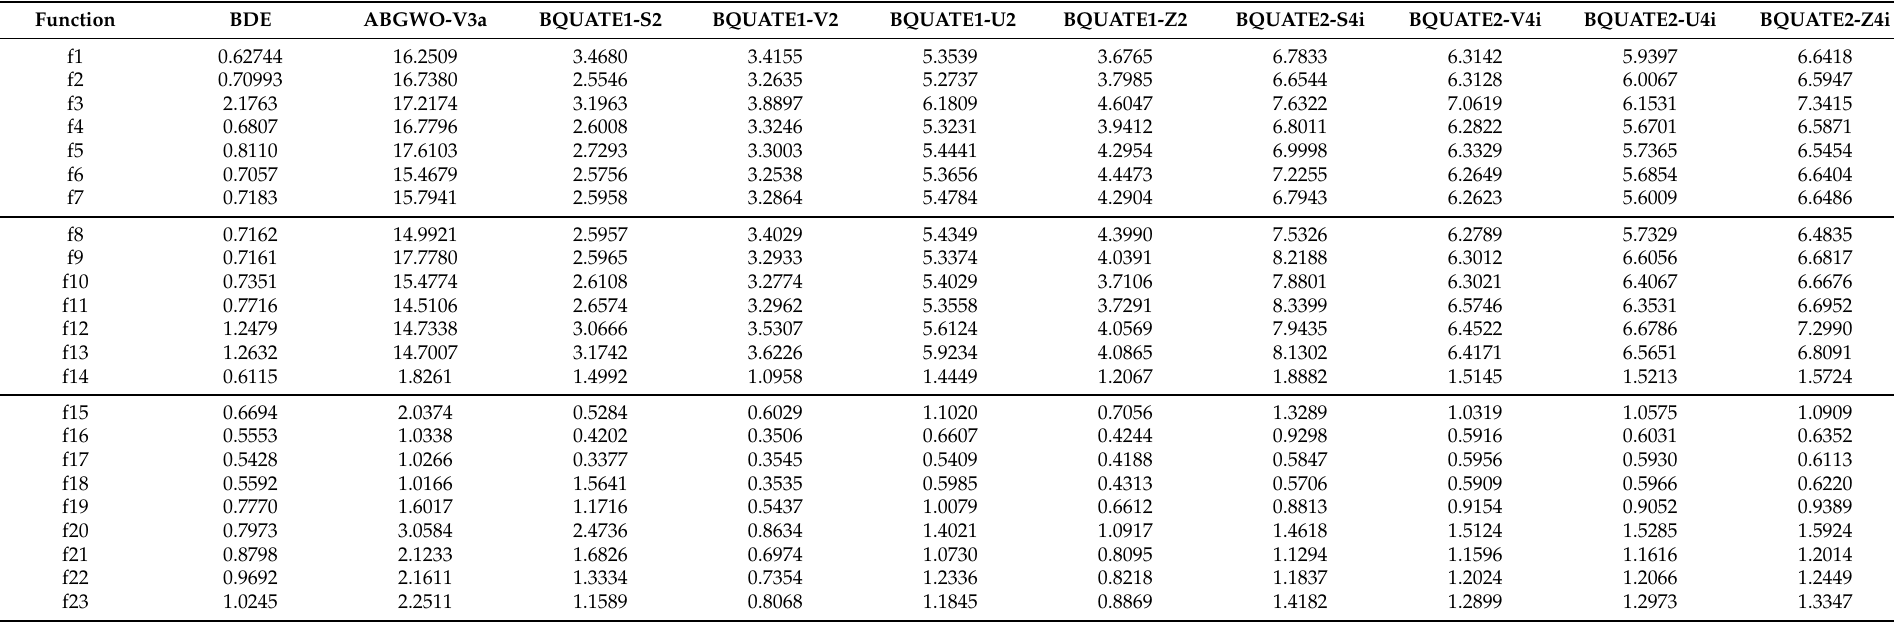
Table 17. The time consumption of the algorithms(BDE, ABGWO-V3a, BQUATE1-S2, BQUATE1-V2, BQUATE1-U2, BQUATE1-Z2, BQUATE2-S4i, BQUATE2-V4i, BQUATE2-U4i, and